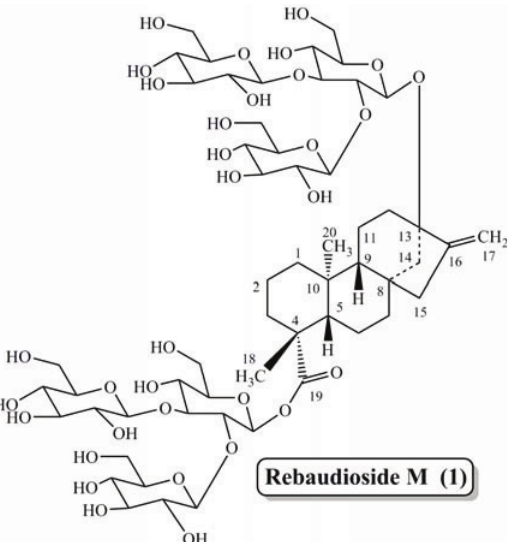
Figure 1. Structure of rebaudioside M ( 1